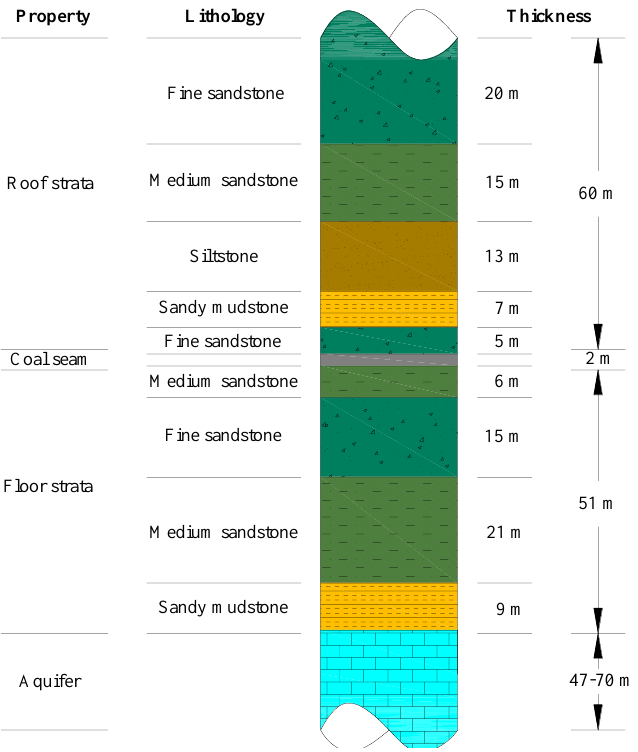
Figure 8. Mesh division and boundary conditions of numerical model established using FLAC3D (taking an inclined strata model as an example). ( a ) mesh division; ( b ) boundary conditions.